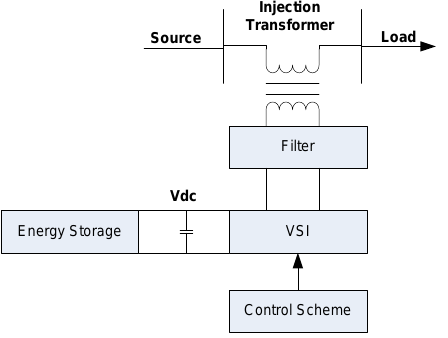
Figure 6. A general representation of a Dynamic Voltage Restorer [97].